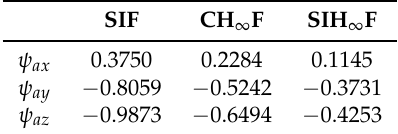
Table 3. Estimation error of the van test ( ◦